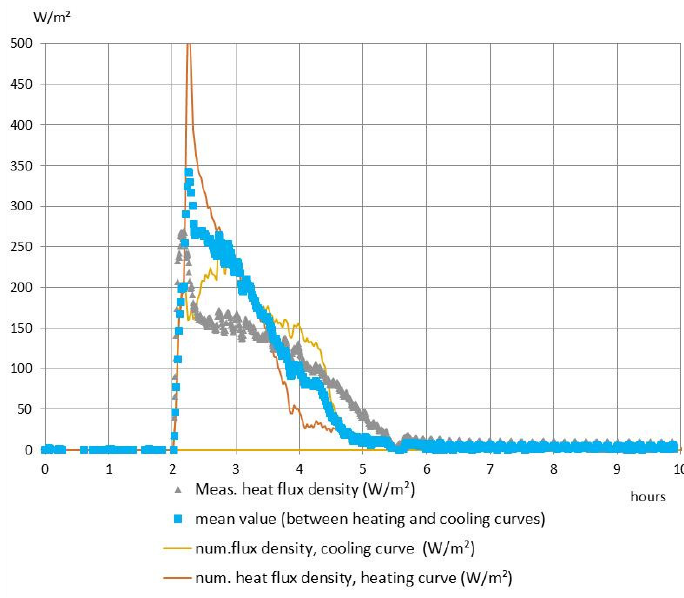
Figure 7. 2D results of mean heat flux to surface container for cooling case: heating, cooling heat capacity curves and mean value.